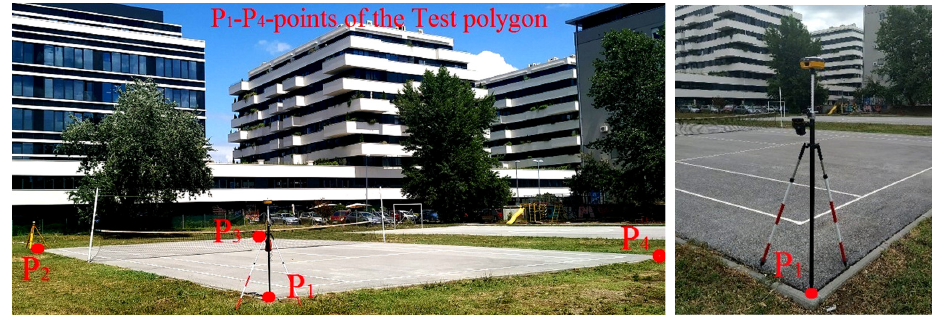
Figure 5. Measurements in the Test polygon—GNSS RTK mode (point P 1 of the Test polygon).